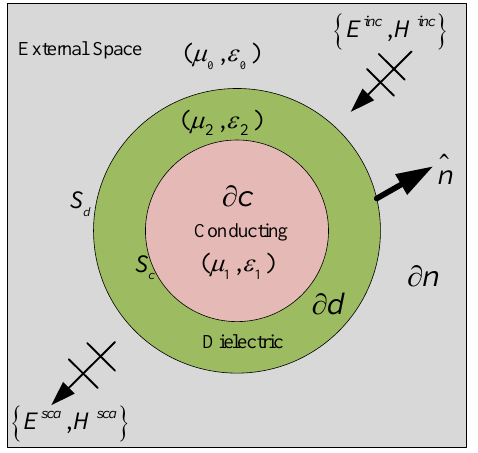
Figure 2. Configuration of perfect electrical conducting coated with dielectric. The equivalent external problem is shown in Figure 3a. The electric field and mag- netic field of the region are assumed to be zero, and the permittivity and permeability of the region are the same as that of the region